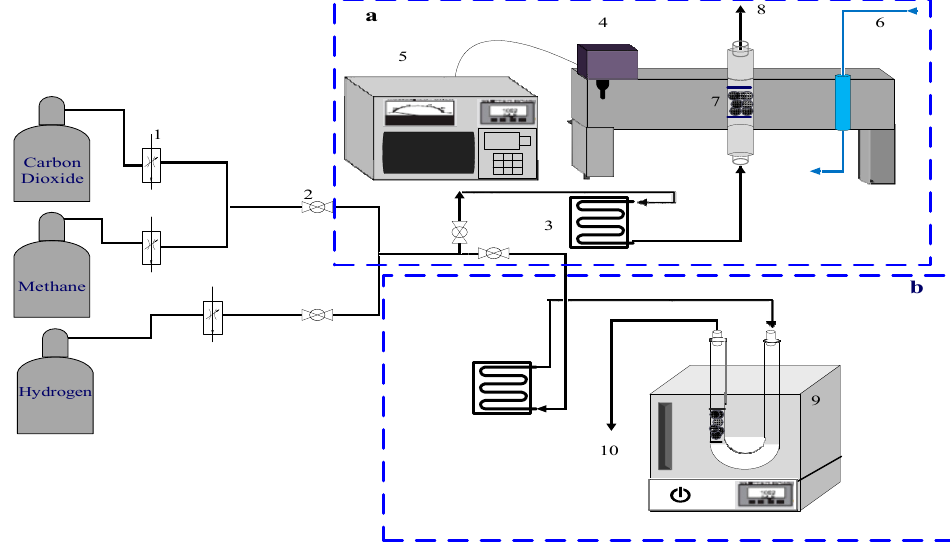
Figure 7. Schematic diagram of ( a ) microwave and ( b ) conventional setups for methane dry reforming. (1) Mass flow controller. (2) Ball valve. (3) Preheater jacket. (4) Microwave magnetron (5) Microwave power supply. (6) Cooling water. (7) Catalyst bed (quartz tube). (8) Products from microwave reactor. (9) Furnace. (10) Product from conventional reactor.